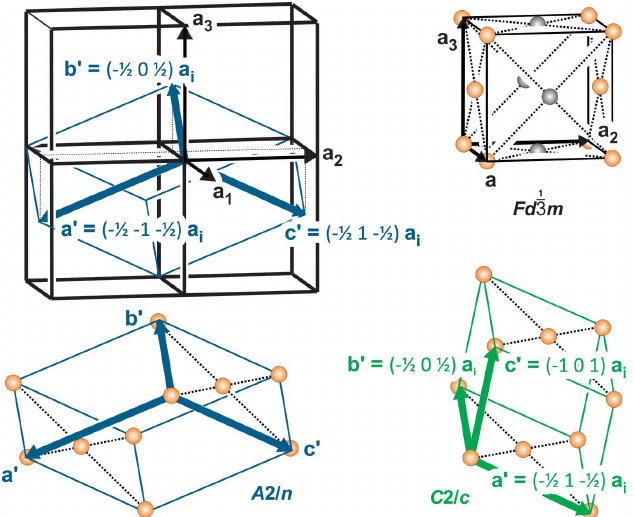
Table 3 Interatomic bond lengths (A˚ ) and bond angles ( (cid:3) ) of chibaite.